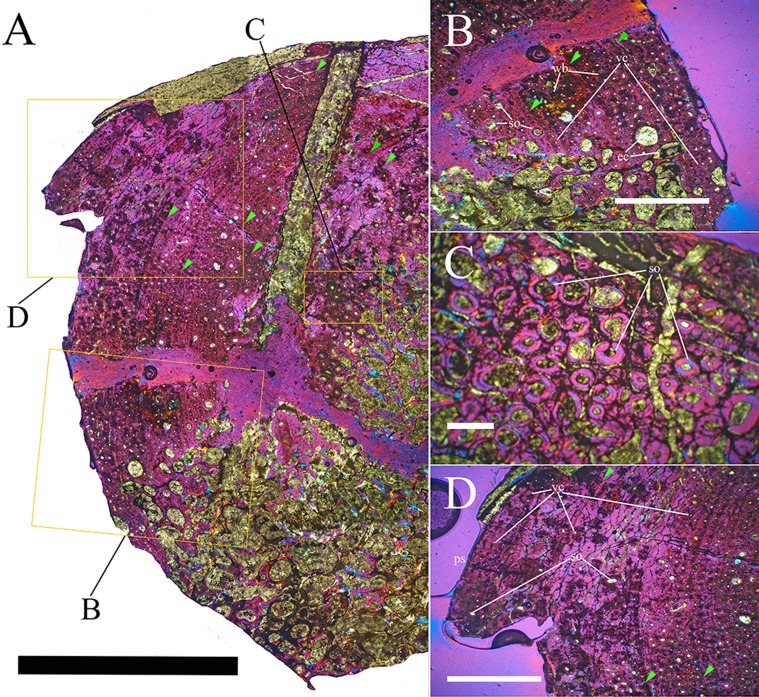
MSNVE 3714, dorsal rib, transverse thin section.Panoramic view of the thin section of the dorsal rib (A); transition between the outer cortex and the medullary cavity (B; note erosional cavities and deep remodeling of the primary bone); Haversian systems in the inner cortex (C); detail of the outermost cortex showing zonation and the absence of an EFS (D). Abbreviations: ec, erosional cavities; ps, periosteal surface; so, secondary osteons; vc, vascular canals; wb, woven bone. Green arrows point to the LAGS. Scale bars equal 10 mm in A, 1 mm in B and D, and 500 µm in C.